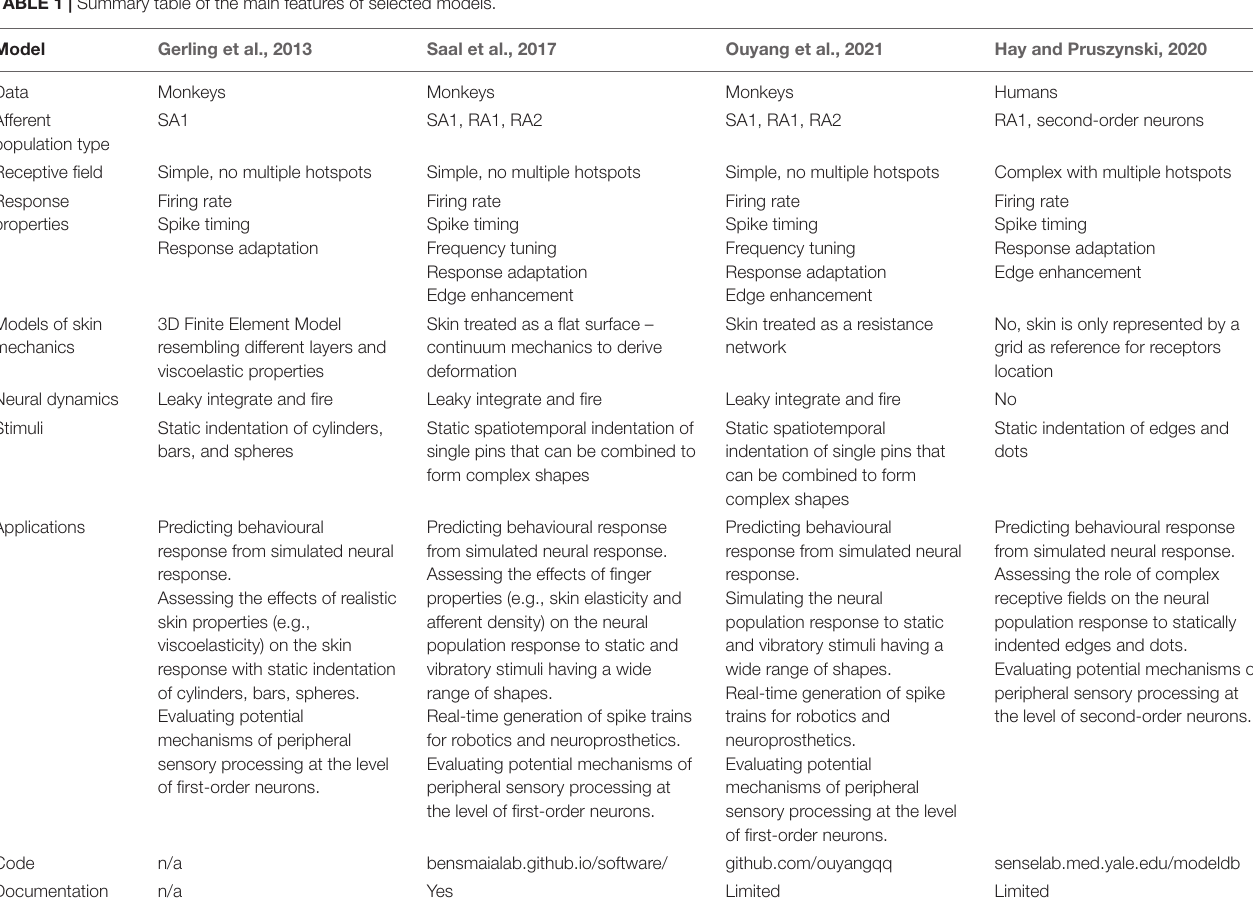
FIGURE 4 | Somatosensory Evoked Potentials (SEP) in rhesus monkeys for several indented letters. Rows from top to bottom show SEPs from one SA1, one RA1, and one RA2, respectively. Image reproduced with the author’s permission (Phillips et al., 1988). TABLE 1 | Summary table of the main features of selected